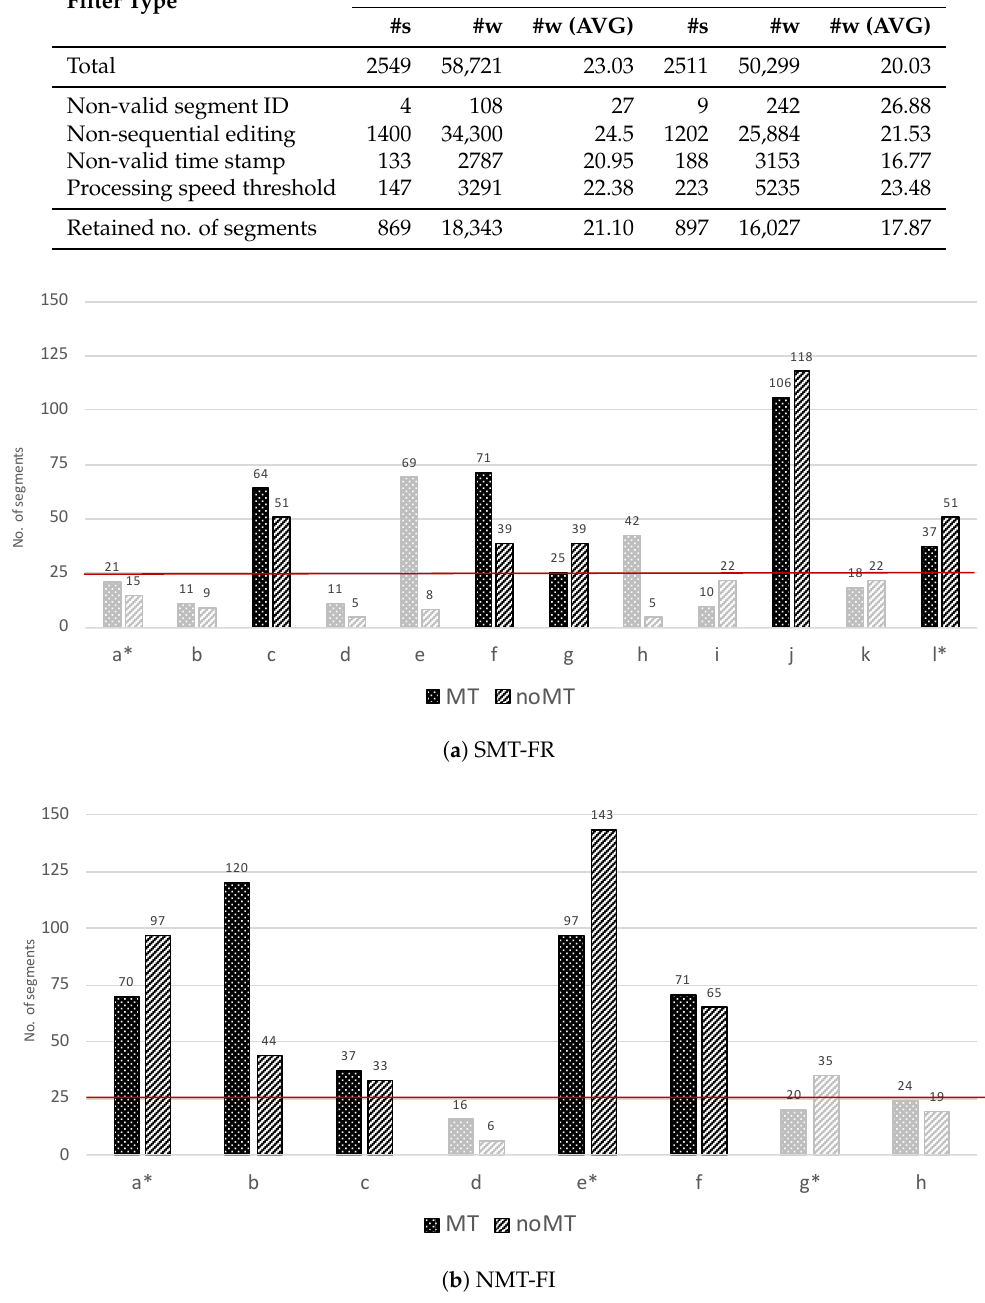
Figure 1. Total number of segments retained per translator at ( a ) The French and ( b ) the Finnish language departments, per segment type. The translators who worked in auto-suggest mode are marked by a